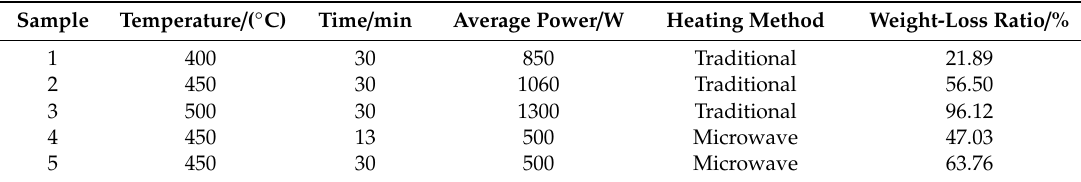
Table 1. Details of samples under di ff erent reaction